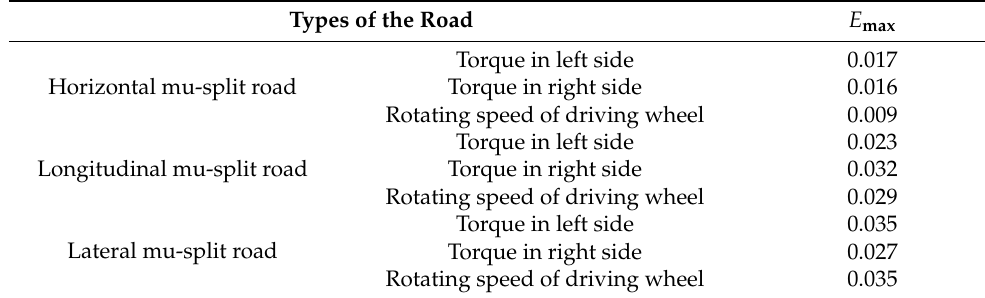
Figure 24. Simulation results of bench test and the actual vehicle movement. Table 3. The error between bench tests and actual vehicle on different types of the